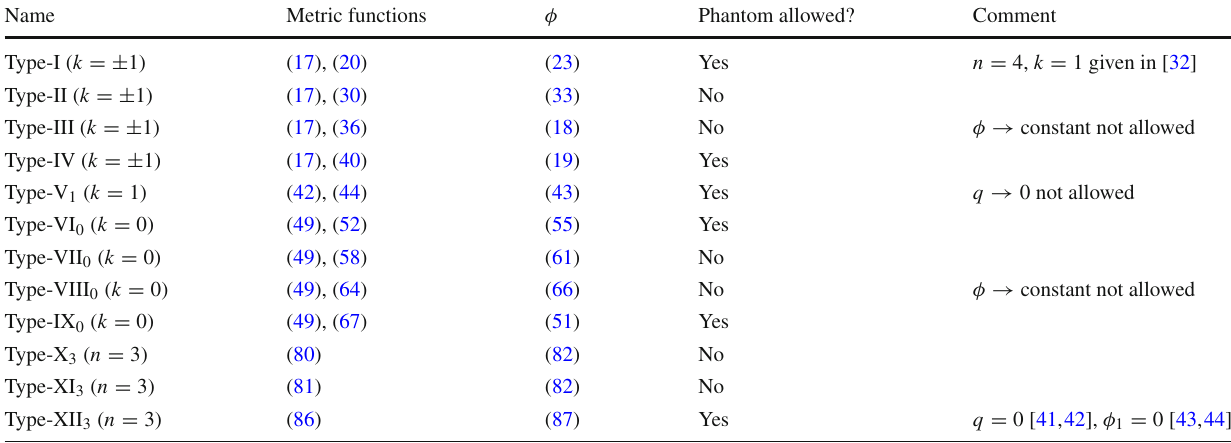
Table 1 Classification of the static solutions. The limit q → 0 is allowed in the solutions (except for type-V 1 ), where φ( x ) then nec- essarily becomes constant in the solutions IV and IX 3 –XI 3 . The limit to constant φ is allowed in the solutions (except for type-III and VIII 0 ),